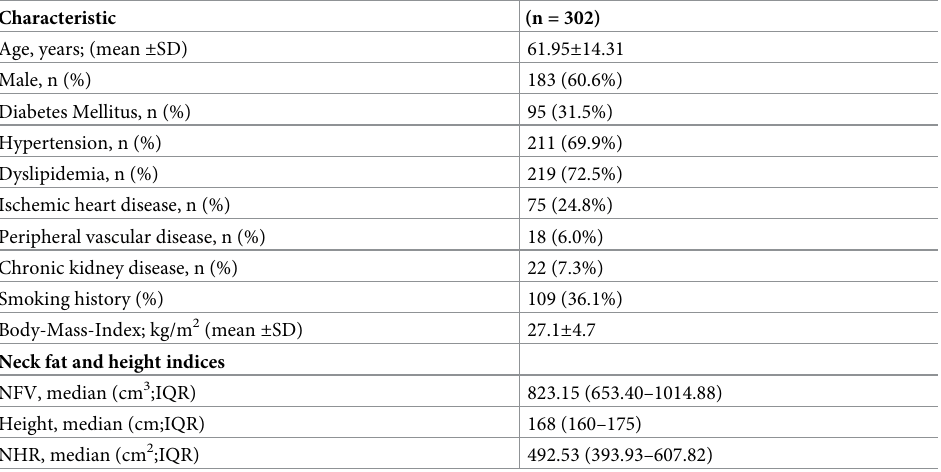
Table 1. Study population descriptive